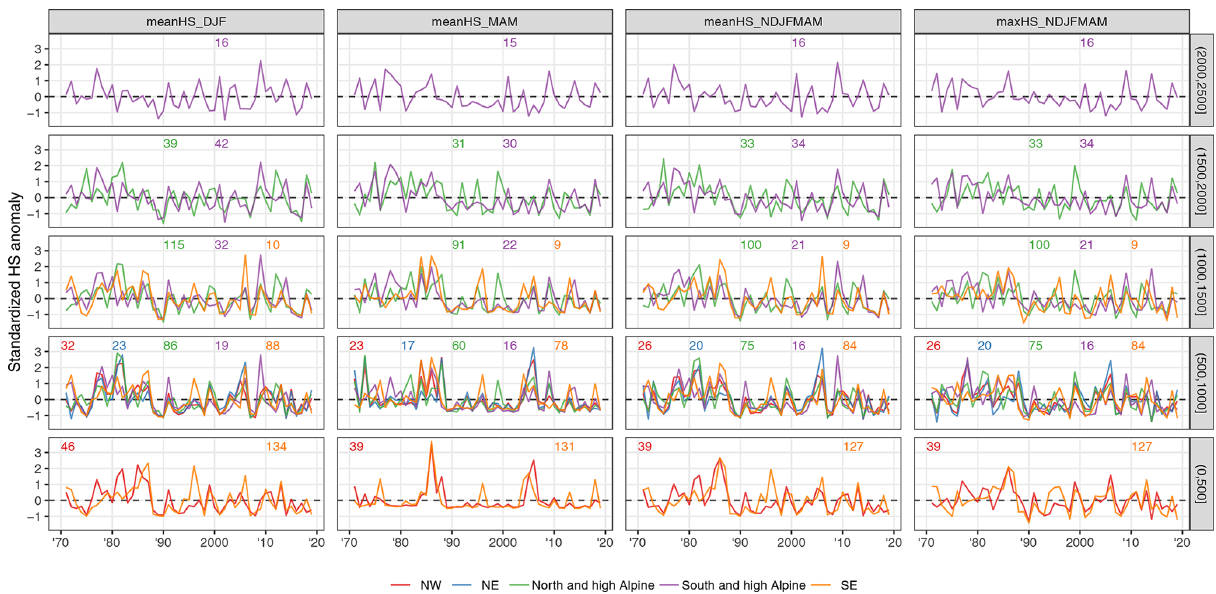
Figure C4. Same as Fig. C3 but for standardized